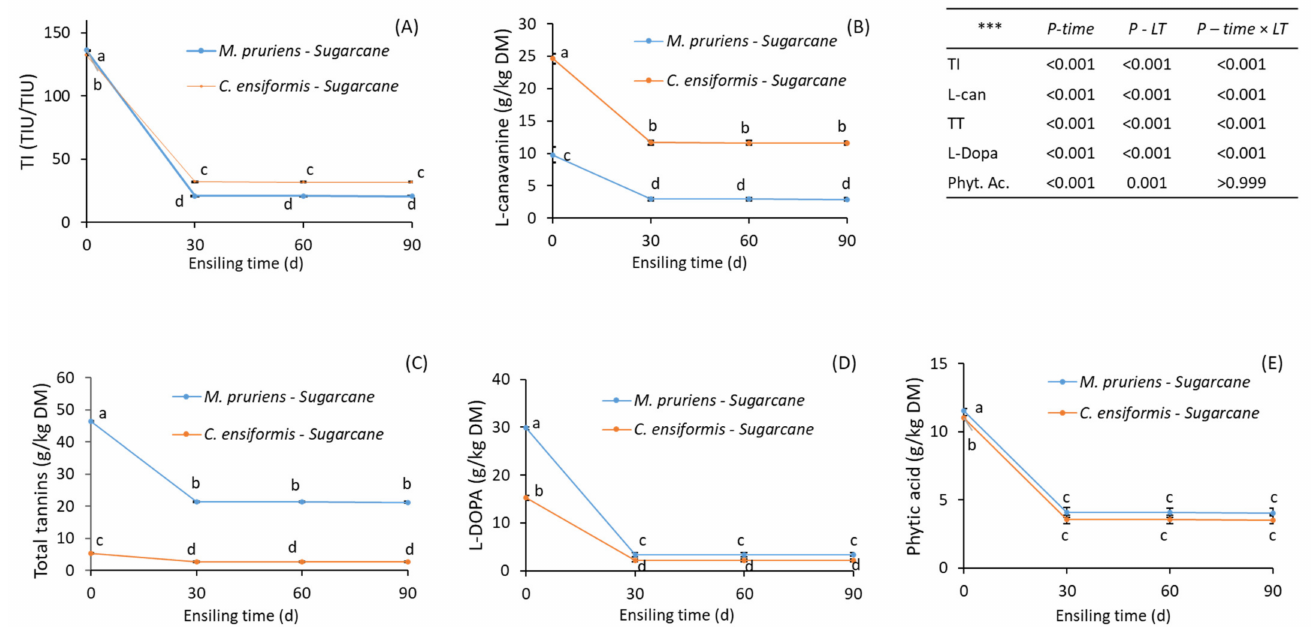
Figure 1. Effect of ensiling process on PSM concentrations ( A ) TI (trypsin inhibitor), ( B ) L-canavanine, ( C ) Total tannins, ( D ) L-dopa, and ( E ) Phytic acid] of mixed C. ensiformis –sugarcane and M. pruriens – sugarcane silage. *** upper right table: L-can (L-canavanine), TT (total tannins), Phyt. ac.